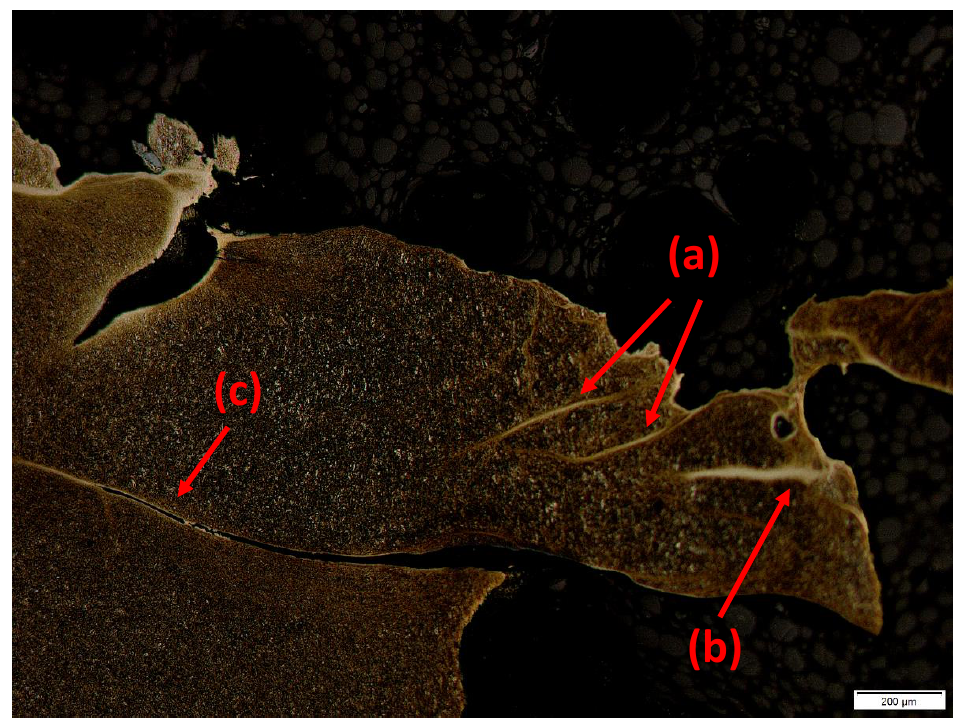
Figure 16. Metallographic analysis of plate impacted at 1141 m/s with an h/d = 0.6; ( a ) details of wide dASBs and gradual formation of tASB; ( b ) deformed shear bands (dASB), which are characteristic for early-stage deformations and shear; ( c ) narrow transformed shear band (tASB) created by further development of the dASB .